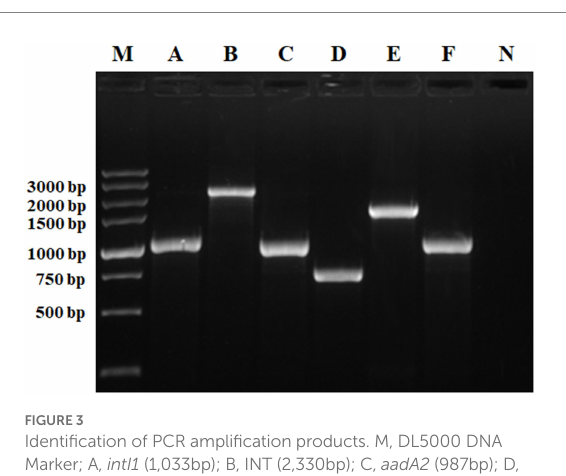
FIGURE 3 Identification of PCR amplification products. M, DL5000 DNA Marker; A, intI1 (1,033 bp); B, INT (2,330 bp); C, aadA2 (987 bp); D, intI1-15 (717 bp); E, INT15 (1,526 bp); F, aadA2-15 (985 bp); N, negative